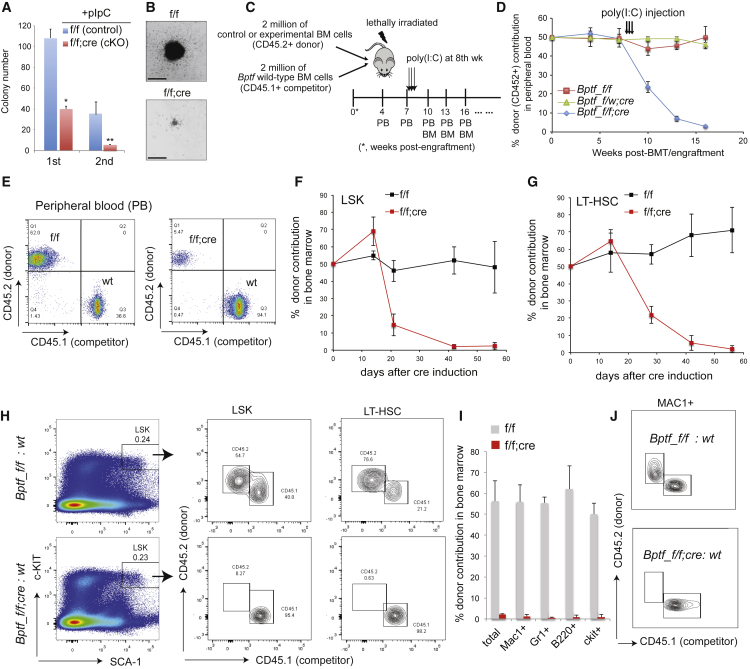
BPTF Is Essential for the Maintenance and Reconstitution Function of HSCs in a Cell-Autonomous Manner(A and B) Summary (A) and representative colony (B; scale bar, 1 mm) in colony-forming unit assays with 300 of the Bptff/f or BptfcKO (f/f; cre) LSK cells sorted 7 days after cre induction (n = 3 independent experiments; ∗p < 0.05; ∗∗p < 0.01; see also Figure S1C).(C) Outline of competitive reconstitution assay via BMT.(D) Percentage of donor-derived CD45.2+ cells from BptfcKO (blue; n = 8 mice) and control mice, either Bptff/f (red; n = 8) or Bptf-/w (green; n = 6), in peripheral blood of recipients at the indicated time points. Error bars denote SE.(E) FACS of donor-derived CD45.2+ cells, either from Bptff/f or BptfcKO mice, in peripheral blood 5 weeks after cre induction.(F–H) Summary (F and G; n = 2 mice at each time point) and FACS (H) of donor-derived CD45.2+ cells, either from control (Bptff/f) or BptfcKO mice, in the BM LSK and LT-HSC populations 8 weeks after cre induction (see also Figure S1D).(I and J) Percentage (I; n = 4 mice) and FACS (J) of donor-derived CD45.2+ cells from Bptff/f or BptfcKO mice in the indicated BM populations 8 weeks after cre induction (see also Figures S1E and S1F).